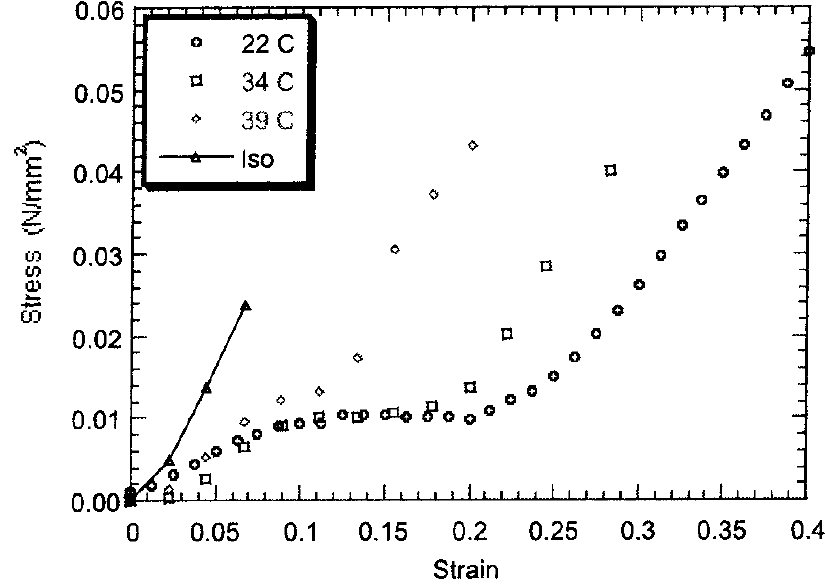
Figure 2. Typical stress-strain plots for a polydomain nematic liquid crystal elastomer (NLCE) consisting of polysiloxane backbone, rod-like mesogens as side group, and a point-like “tri-functional” crosslinker. The strain on the horizontal axis represents fractional extension ( i.e. , Δ L / L = λ − 1) of the sample. Reproduced with permission 0 from [44]. Copyright 1998 American Chemical